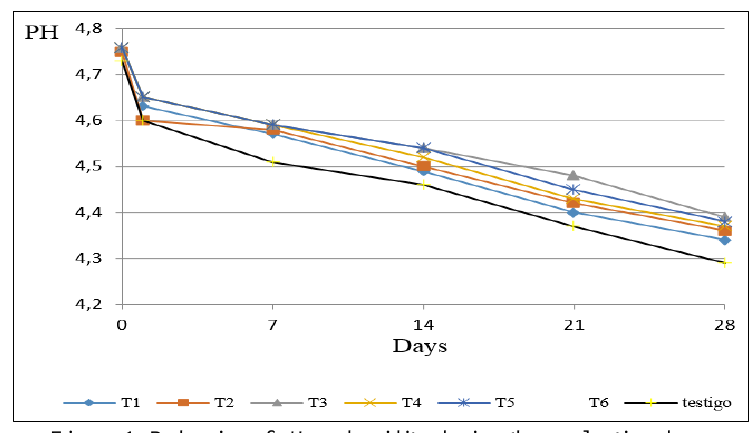
Figure 1: Behavior of pH and acidity during the evaluation days.